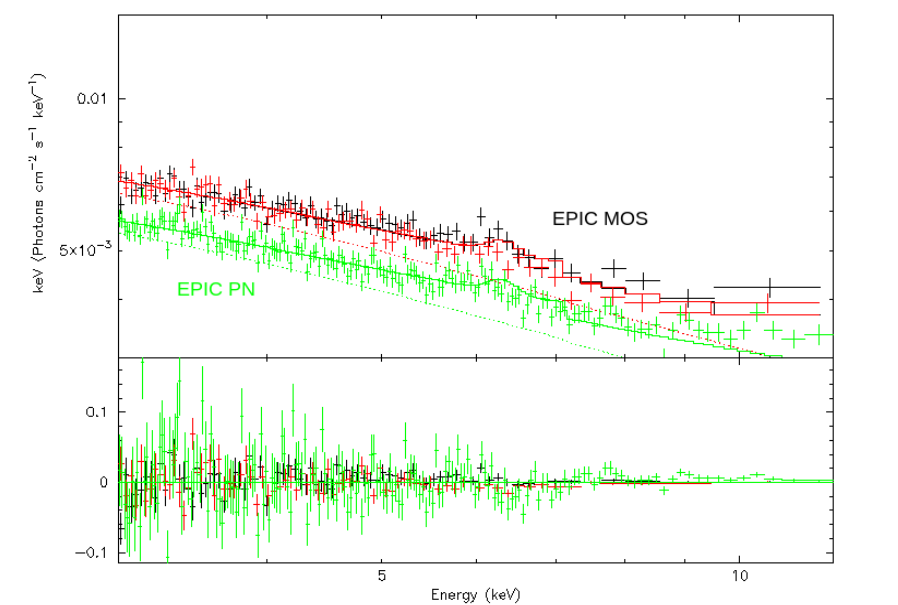
Figure A1. Unfolded XMM-Newton EPIC MOS and PN spectra of 3C 111 during 1st (March 2001) observational period and model. Above: all the spectra are shown by crosses; fitting curves are shown by solid lines; model components are shown by dotted lines; below: data residuals. During this period jet base emission was dominating slightly over nuclear one; signs of weak Fe-K α emission line are present.